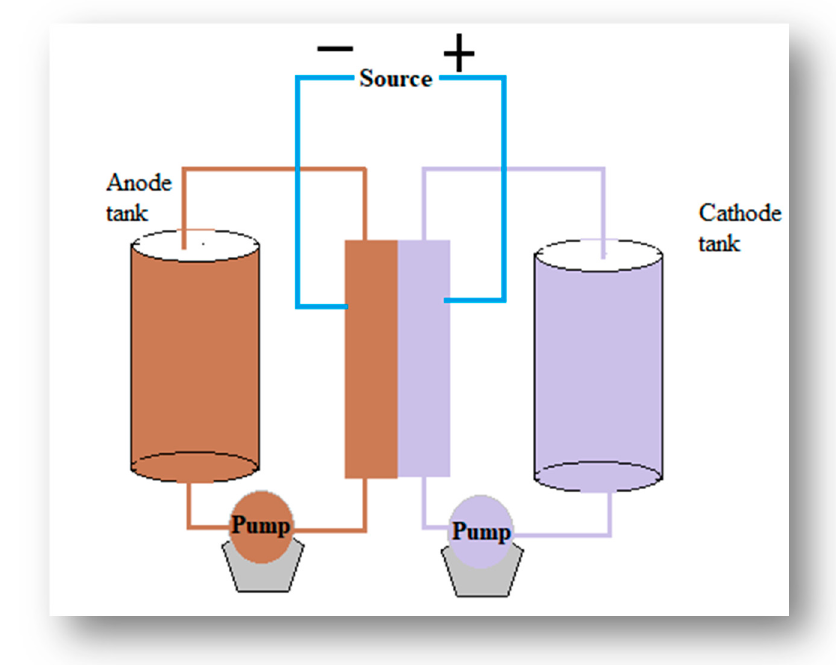
Figure 7. Schematic of redox flow battery.